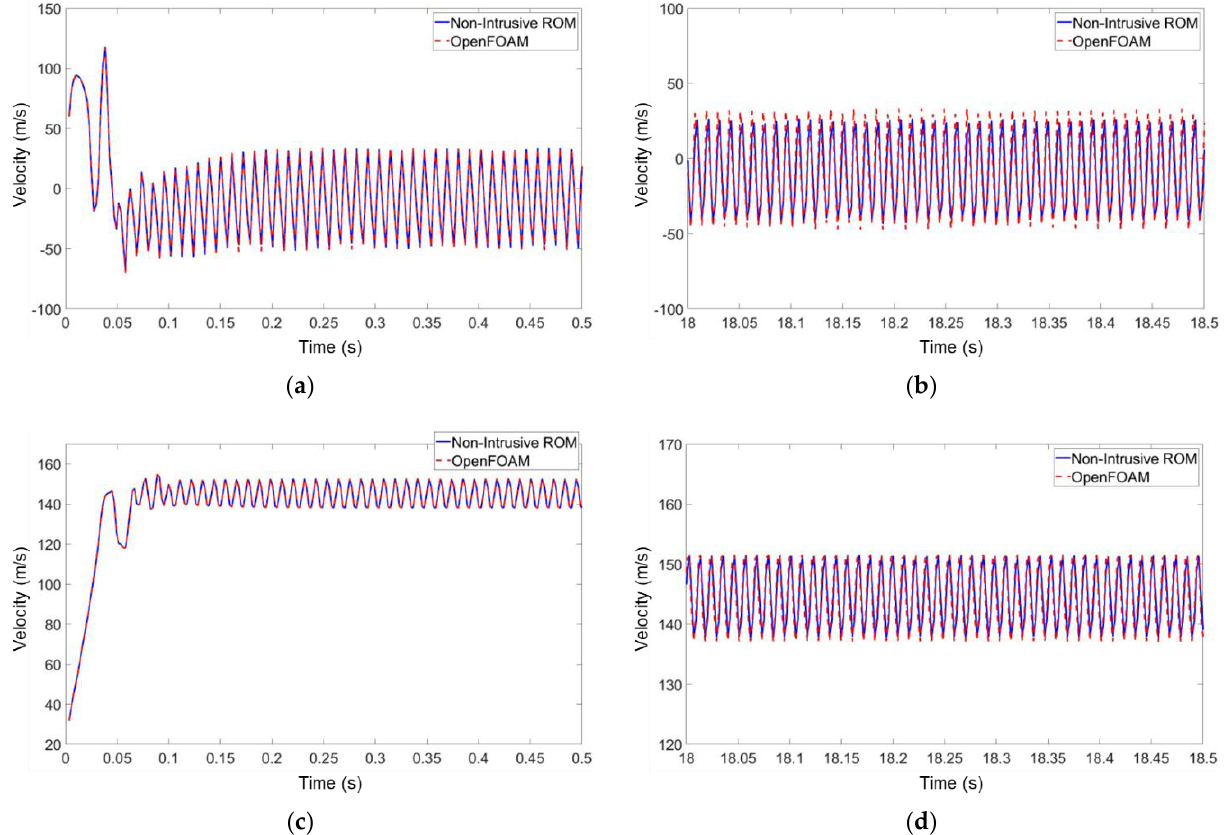
Figure 10. Example 2: Comparison of x-directional velocity profiles of the proposed ROM and OpenFOAM at several locations: ( a ) 0 – 0.5 s at (4.1175, 2.9034); ( b ) 18 – 18.5 s at (4.1175, 2.9034); ( c ) 0 – 0.5 s at (7.1536, 1.9996); ( d ) 18 – 18.5 s at (7.1536, 1.9996).